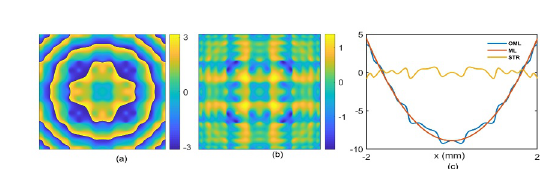
Figure 2. (a) Single period of the optimized mDOE array. (b) Single period of the subtracted structure of the mDOE from the microlens, (c) profiles of the phase structures at single periods of